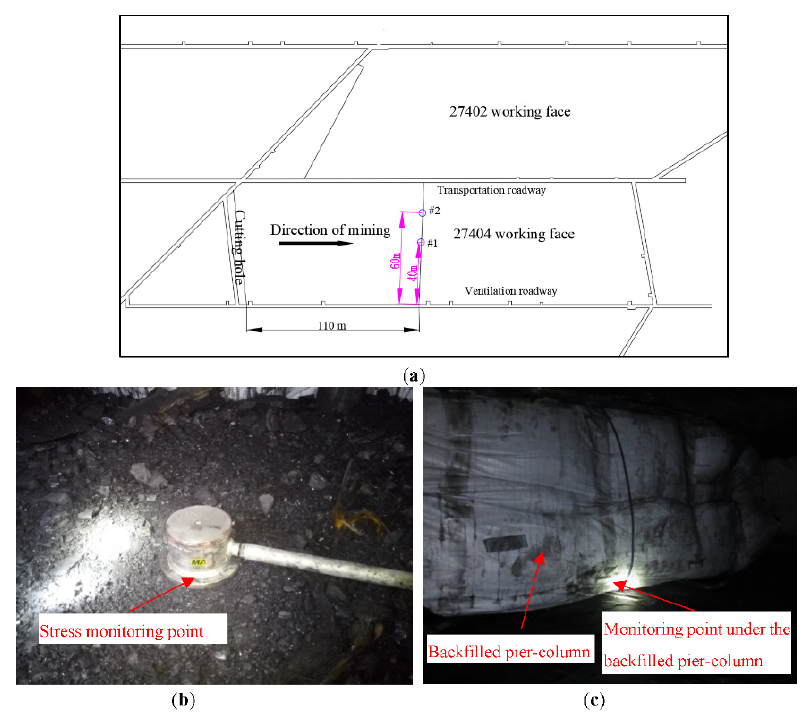
Figure 11. Field testing: ( a ) the arrangement of the stress monitoring points in working face 27404; ( b ) before pier-column backfilling; ( c ) after pier-column backfilling.